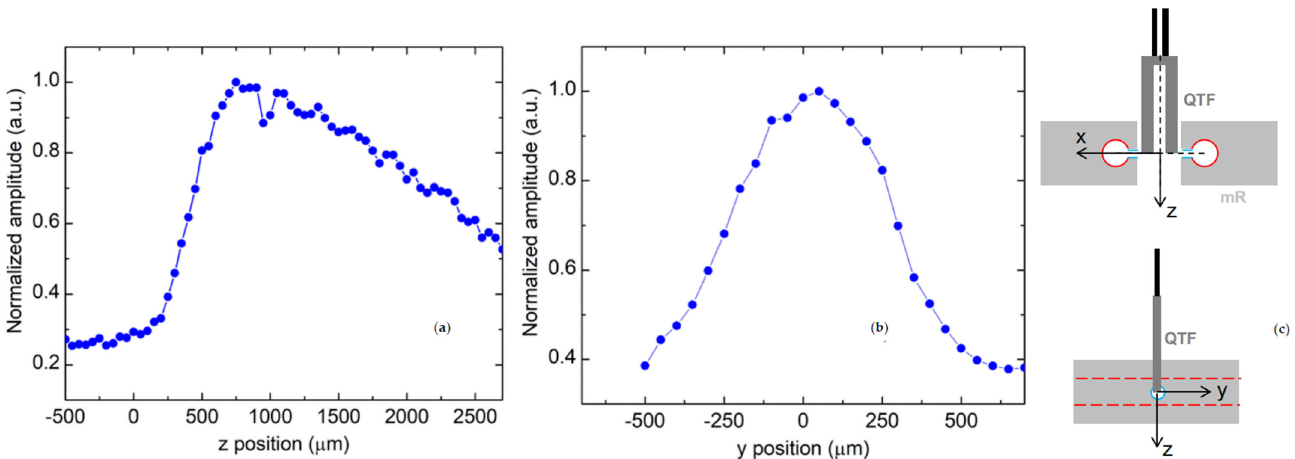
Figure 6. Evolution of the QEPAS signal when moving the QTF in the z ( a ) and y ( b ) direction. ( c ) Schematic of the mR and the QTF in the defined referential. The QTF is represented in the (0, 0, 0) position.